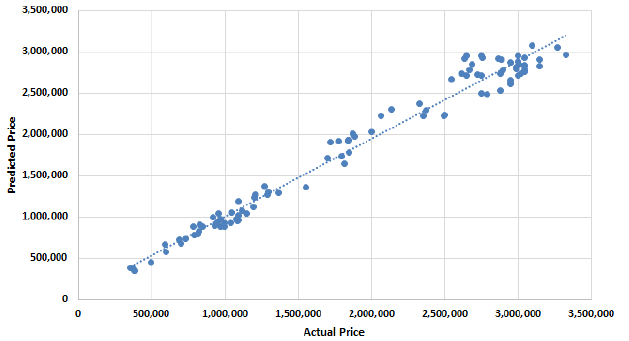
Figure 20. Predicted price versus actual price of 100 records.